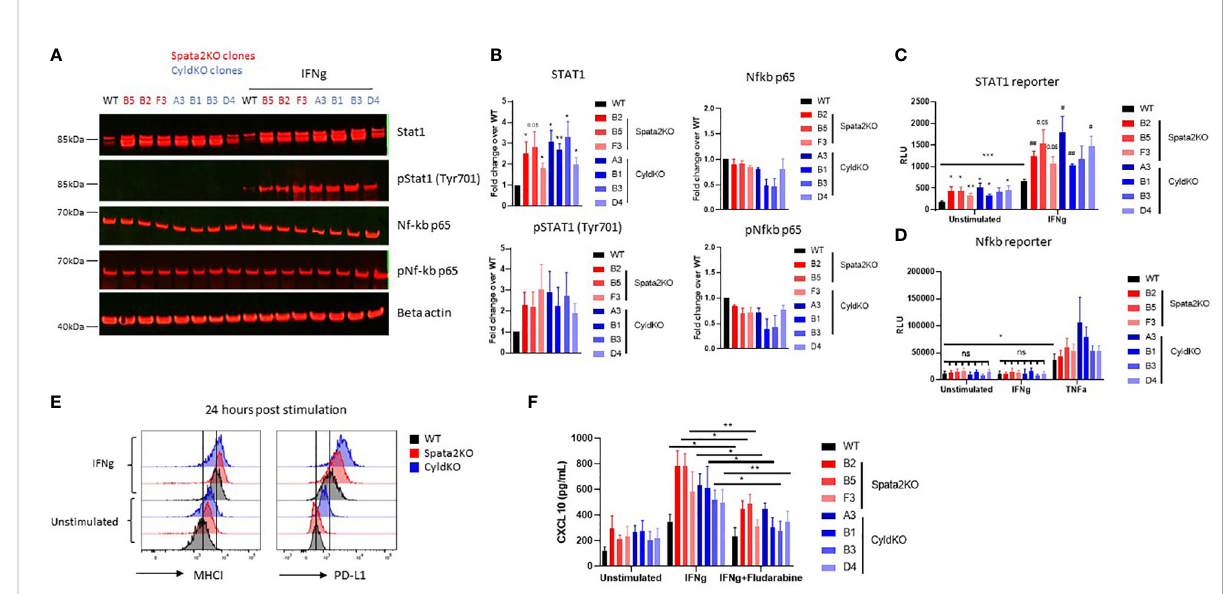
FIGURE 3 SPATA2 and CYLD regulate STAT1 accumulation and activation in CT26 cells. (A) STAT1, phospho-STAT1, NF- k B p65 and phospho-NF- k B p65 protein expression was measured by Western blot in untreated or IFN- g -stimulated WT, Spata2- KO, and Cyld -KO CT26 clones. (B) STAT1 and NF- k B p65 protein quanti fi cation from Western blots at baseline (top panel); phospho-STAT1, and phospho NF- k B p65 protein quanti fi cation from Western blots from IFN- g -stimulated samples (bottom panel). * p<0.05, ** p<0.01 (Paired Student ’ s t test of each condition vs. WT cells). Results are representative of 3-5 independent experiments (A, B) . (C) STAT1 activity at baseline and in response to IFN- g was measured in CT26 WT and KO cells transfected with STAT1-reporter lentiviral particles. Results are representative of 5 independent experiments. * p<0.05, ** p<0.01, *** p<0.001 (Paired Student ’ s t test of each condition vs. unstimulated WT cells). # p<0.05, ## p<0.01 (Paired Student ’ s t test of stimulated KO cells vs. IFN- g -treated WT cells). (D) NF- k B activity at baseline and in response to IFN- g or TNF- a was measured in CT26 WT and KO cells transfected with a NF- k B reporter plasmid. Results are representative of 4 independent experiments. ns: not signi fi cant, * p<0.05 (Paired Student ’ s t test). (E) Class I MHC and PD-L1 expression was measured by fl ow cytometry 24 hours after IFN- g stimulation. Results are representative of 3 independent experiments. (F) CXCL10 protein levels in the supernatant of the indicated CT26 clones 24 hours after treatment with IFN- g or IFN- g + Fludarabine was measured by ELISA. * p<0.05, ** p<0.01 (Paired Student ’ s t test). Mean ±